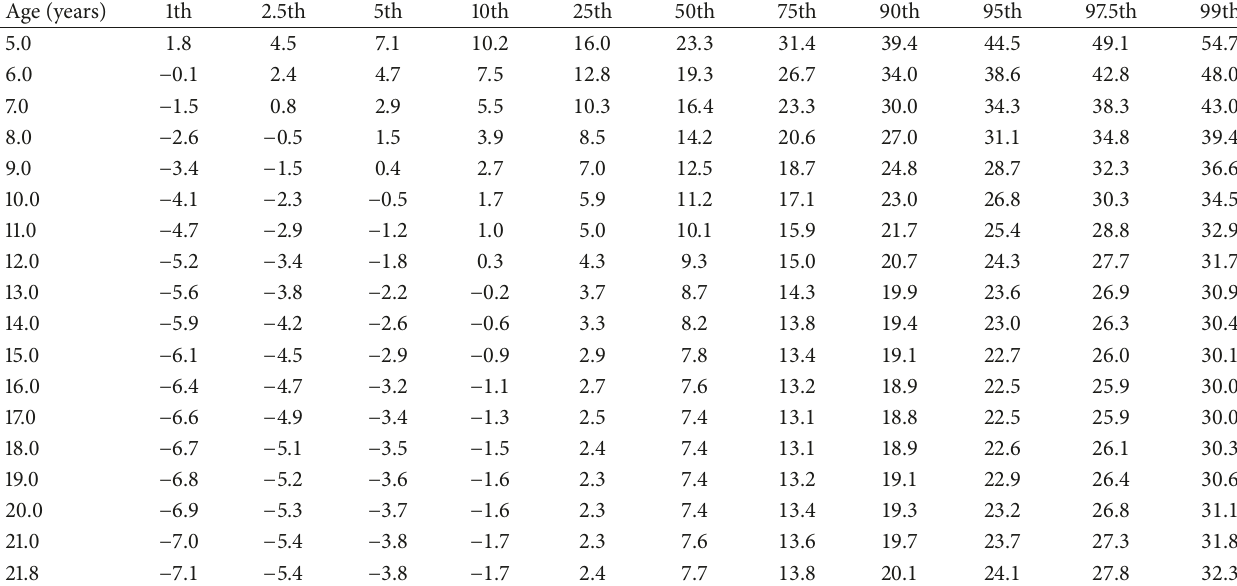
Table 7: Age-related reference intervals (RIs) for central (aortic) augmentation index (cAIx) for the entire population ( 𝑛 = 1038